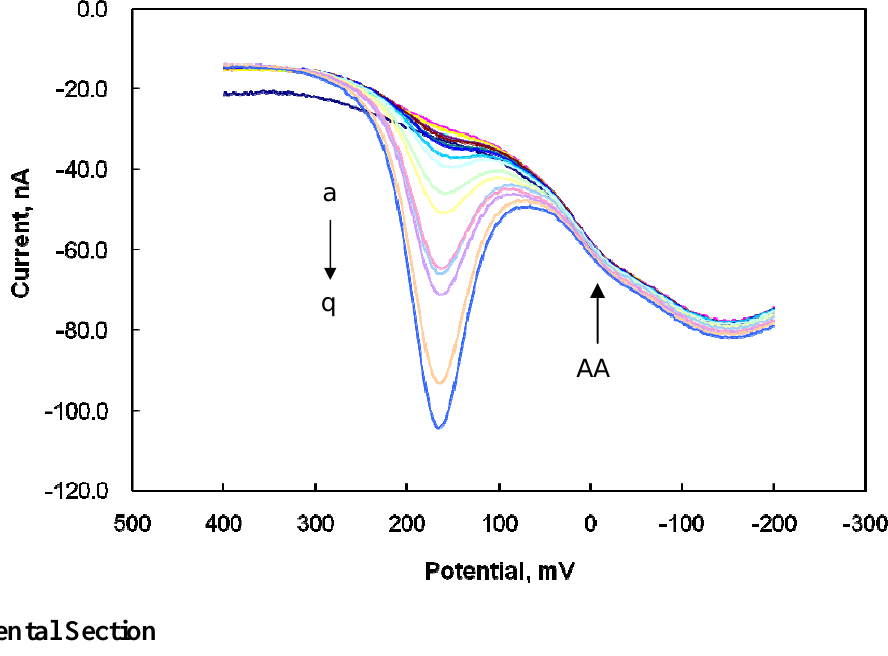
Figure 6. OSWV voltammograms of 1.0 mM AA in the presence of concentrations of DA of 0.0, 0.01, 0.1, 0.2, 0.3, 0.4, 0.5, 0.6, 0.8, 1.0 2.0, 3.0, 4.0, 5.0, 6.0, 8.0, and 10  M DA (a-q, respectively) at the modified microelectrode in a PBS solution at pH 7.4. Inset: plot of oxidative current vs. DA concentration in the constant AA concentration of 1.0 mM with 2 mV step potential, 25 mV amplitude, and 10 Hz